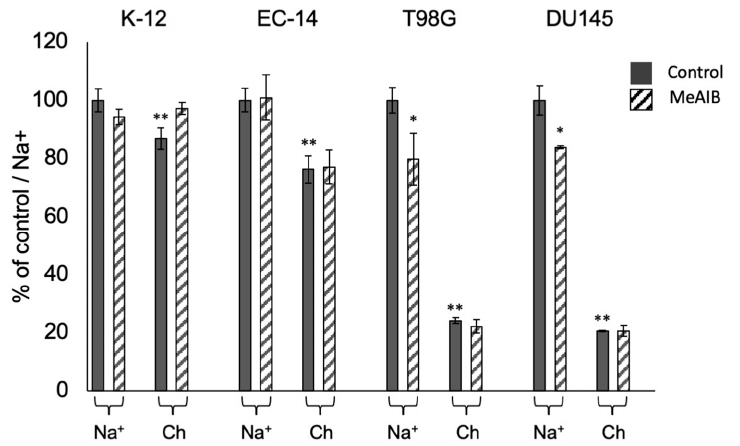
Figure 4. Accumulation of L-Ala in E. coli K-12 and EC-14. Accumulation was compared with that in human tumor cells (i.e., DU145 human prostate cancer cells and T98G human glioblastoma cells) under control and specific inhibitor of system A, MeAIB-treated conditions. For L-Ala, comparing the accumulation of labeled amino acids in Ch-PBS (Na + -free medium) and the accumulation of labeled amino acids in Na + -PBS, 13% of K-12 and 24% of EC-14 were Na + -dependent. Moreover, comparing the inhibitory effect of MeAIB on L-Ala accumulation, K-12 and EC-14 showed no sig- nificant inhibitory effect on L-Ala accumulation by MeAIB, which is observed in tumor cells. * p < 0.05, ** p < 0.01 vs. control/Na+. 2.5. Biological Distribution of E. coli EC-14 Infection Model Mice Using 3 H- L -Ala Table 1 shows the biological distribution of 3 H-L-Ala in EC-14 infection model mice. 3 H-L-Ala showed a maximum contrast of 1.2 at 2 h after infection, 60 min after 3 H-L-Ala injection. This contrast is defined as the ratio of accumulation by weight of infected and uninfected muscle. The ratios of infected muscle to blood were 0.79 and 0.75 at 2 and 8 h after infection, respectively, and 0.89 and 1.31 at 15 and 60 min after 3 H-L-Ala injection, respectively.